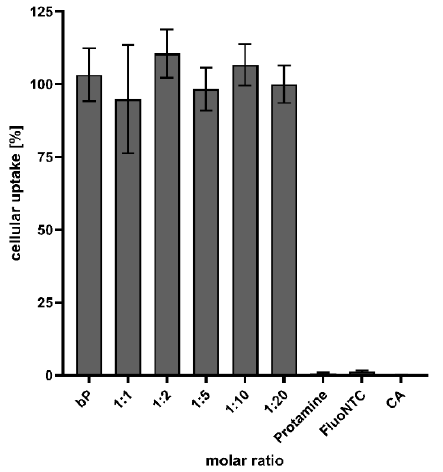
Figure 9. Quantification of proticles and CA-NP uptake. Data are presented as mean values ( n = 6) ± standard deviation and are expressed as a percentage of the uptake, where the uptake of binary proticles (bP) is considered to be 100%. FluoNTC: fluorescence-labeled non-targeting control microRNA; applied FluoNTC concentration = 800 nM. The molar ratio refers to a molar protamine:CA ratio.